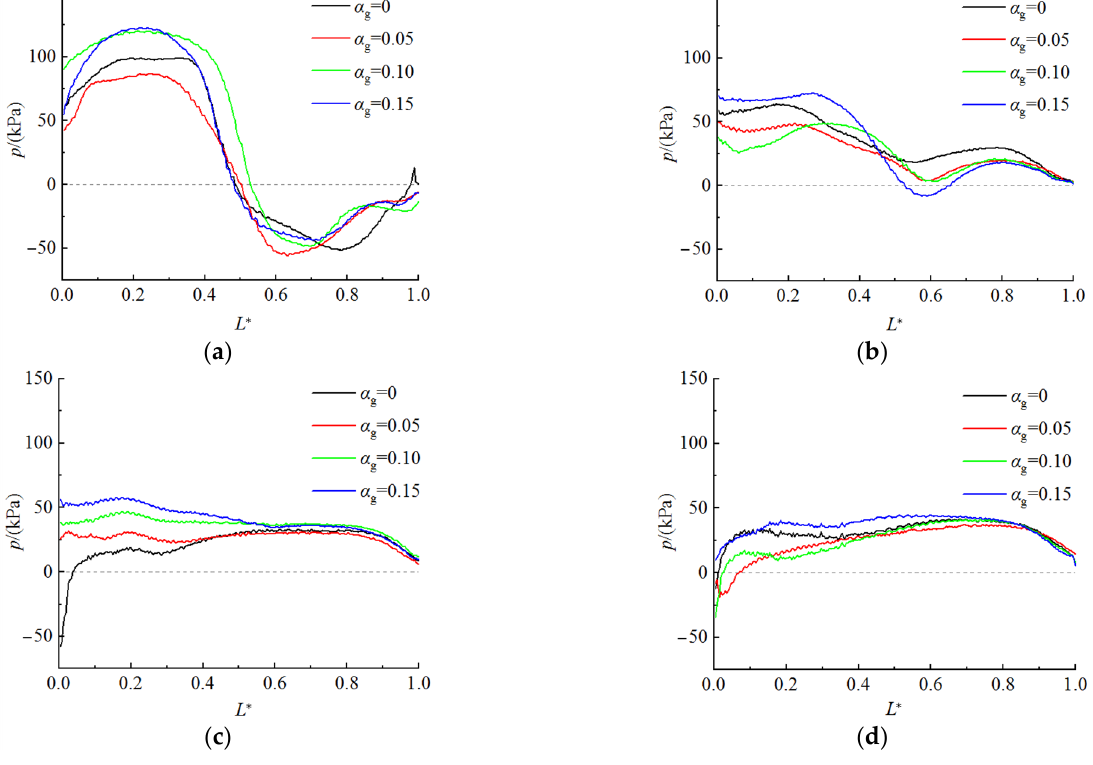
Figure 10. Blade load of PAT during the start ‐ up process. ( a ) t = 1 s; ( b ) t = 2 s; ( c ) t = 3 s; ( d ) t = 4 s.